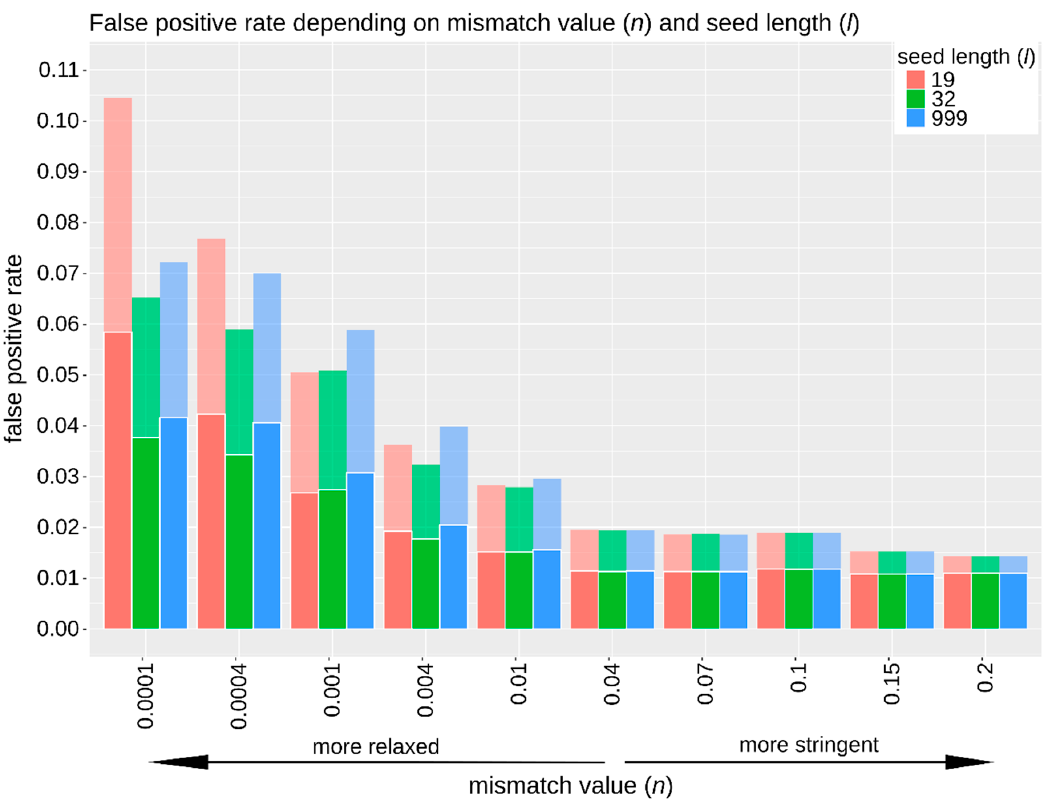
Figure 2. False positive rates calculated from all mapped reads (faded colors) and from all mapped